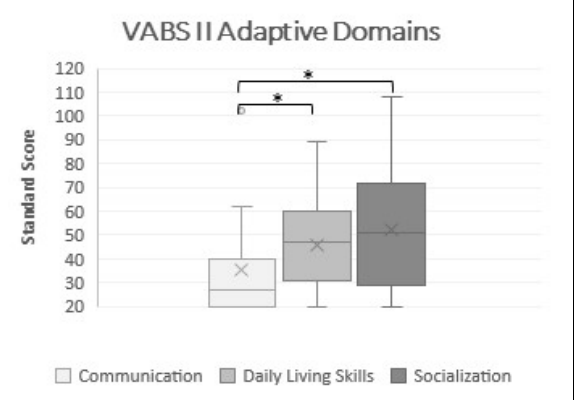
Figure 1. Domain comparisons. Box plots of standard score of VABS II domains, * significant at p ≤ 0.05.